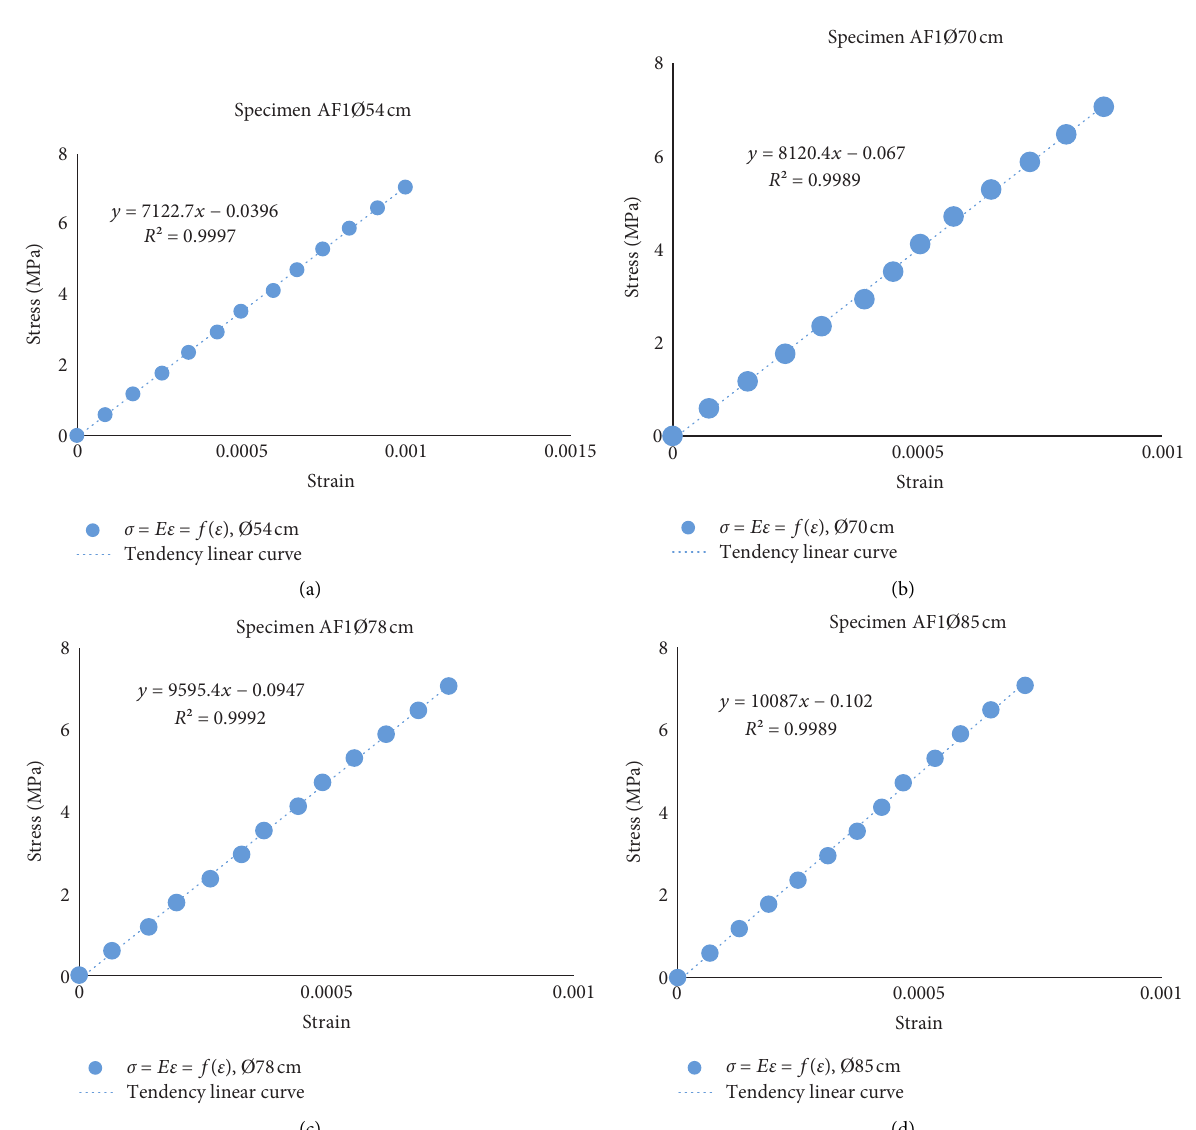
Figure 10: (a, b, c, and d): Samples of linear regression curves used to calculate the